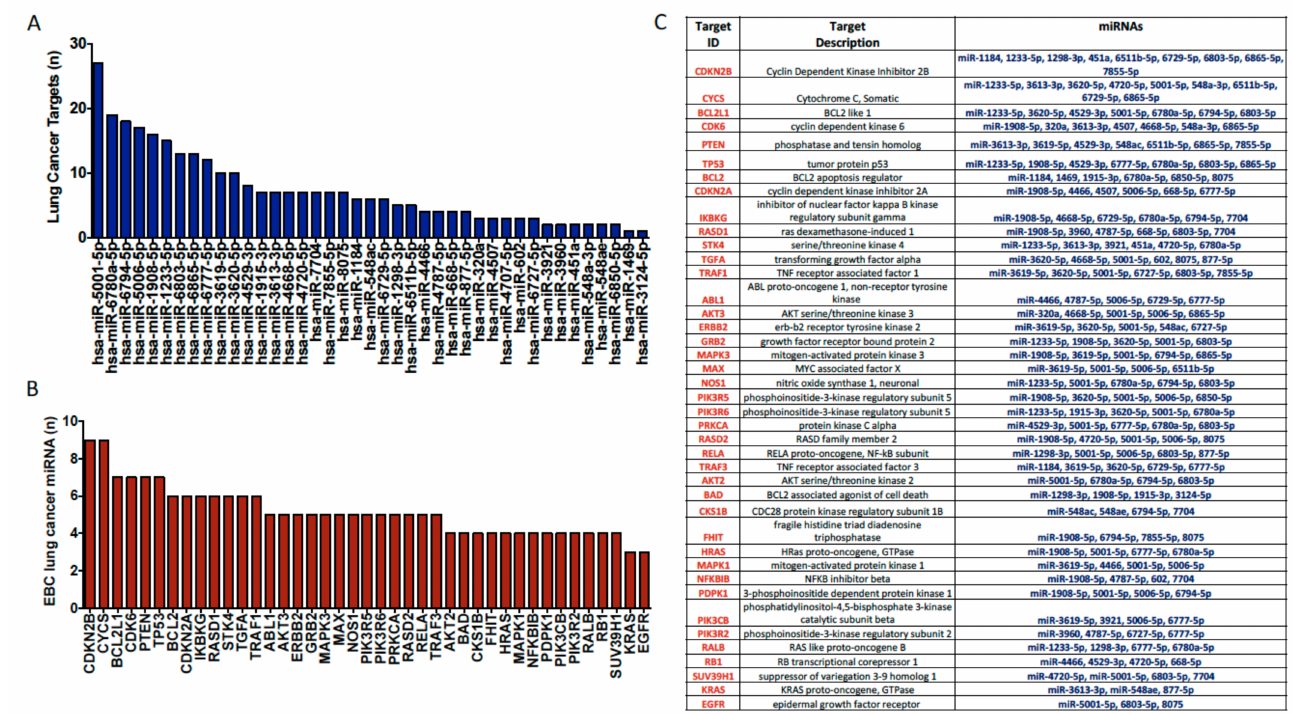
Figure 7. ( A ) Number of potential mRNA targets of the miRNAs identified in EBC that were signatures of lung cancer and associated with its clinical features. Individual miRNAs can simultaneously interact with multiples mRNA targets. ( B , C ) A number of individual lung cancer-associated mRNA targets could be simultaneously regulated by multiples EBC